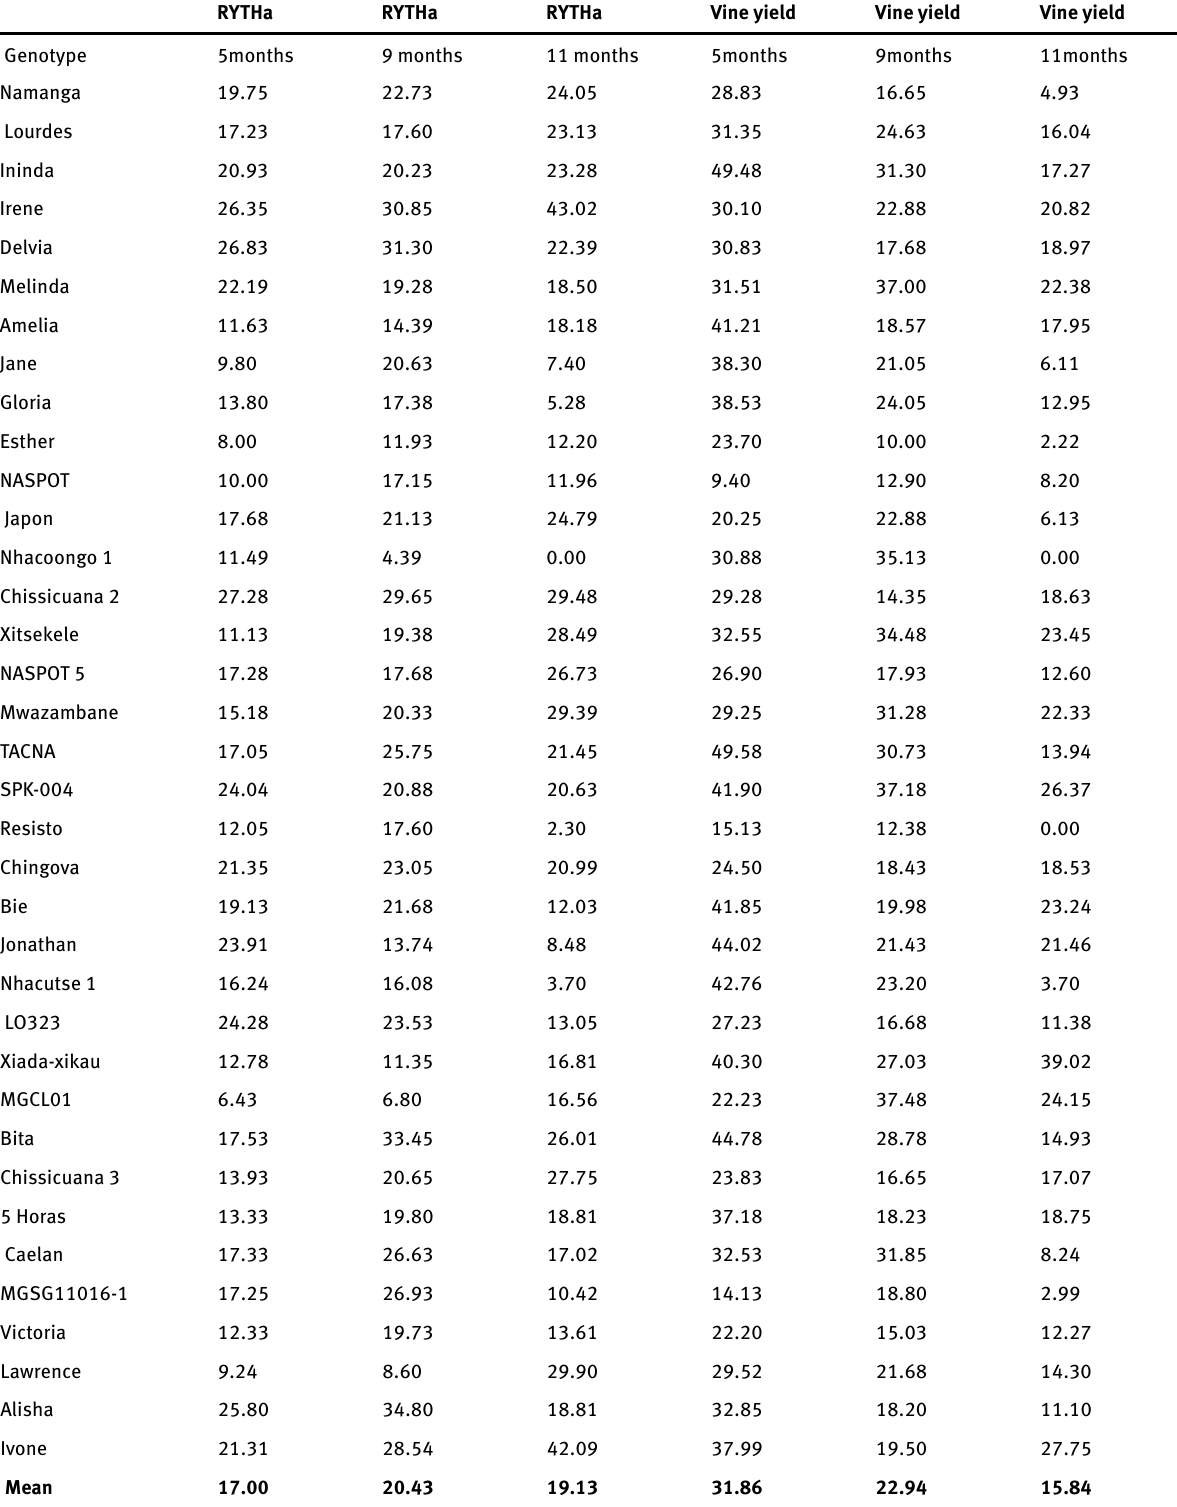
Table 3: Genotypic means for storage root yield (t/ha) and vine yield (t/ha) across Umbeluzi, Nwalate and Gurue in